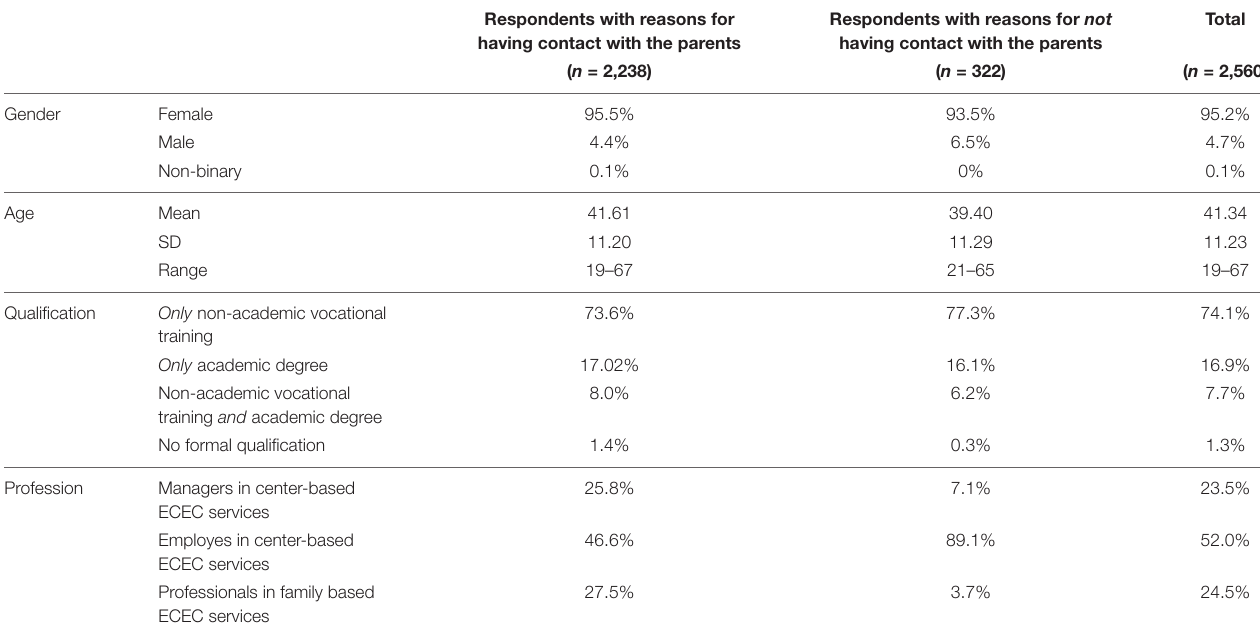
TABLE 1 | Sociodemographic data of participants.